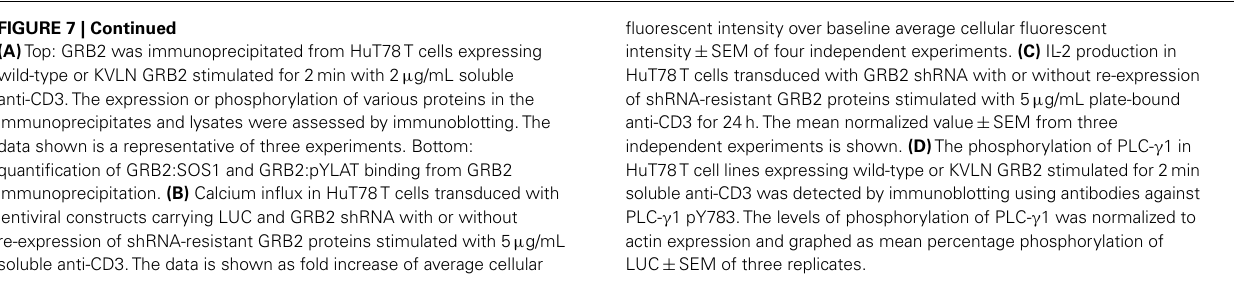
FIGURE 7 | Continued (A) Top: GRB2 was immunoprecipitated from HuT78T cells expressing wild-type or KVLN GRB2 stimulated for 2min with 2 µ g/mL soluble anti-CD3.The expression or phosphorylation of various proteins in the immunoprecipitates and lysates were assessed by immunoblotting.The data shown is a representative of three experiments. Bottom: quantification of GRB2:SOS1 and GRB2:pYLAT binding from GRB2 immunoprecipitation. (B) Calcium influx in HuT78T cells transduced with lentiviral constructs carrying LUC and GRB2 shRNA with or without re-expression of shRNA-resistant GRB2 proteins stimulated with 5 µ g/mL soluble anti-CD3.The data is shown as fold increase of average cellular